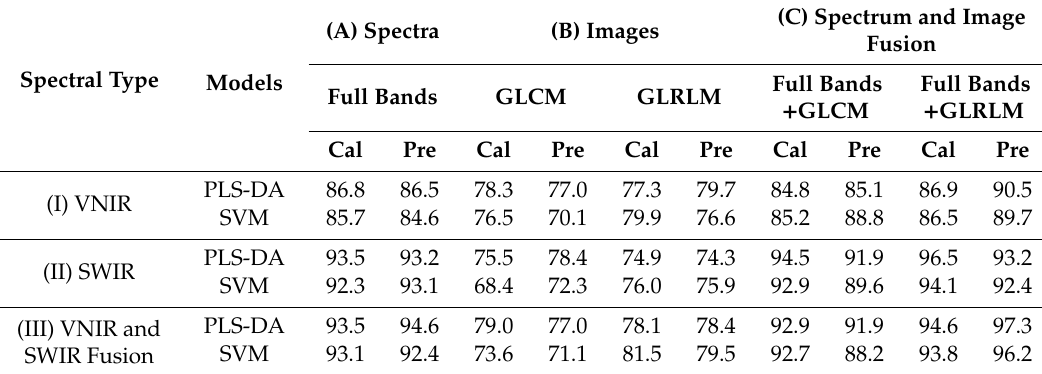
Table 2. The classification accuracies (%) in full bands with partial least squares-discriminant analysis (PLS-DA) and support vector machine (SVM) models (Cal and Pre are the abbreviations of calibration dataset and prediction